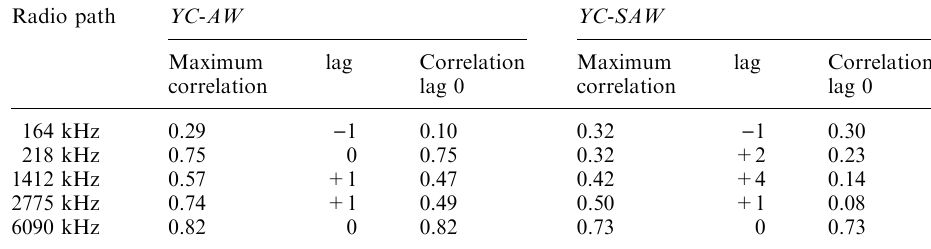
Table 1. Linear trend coe(cid:129)cients for all five radio paths (cid:139)1 r (standard deviation) Radio path Period SAW amplitude 164 kHz noon